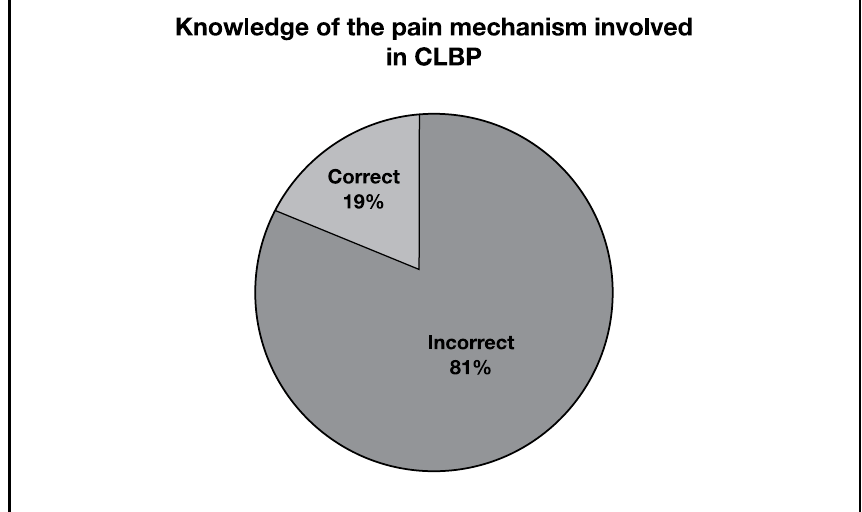
Figure 2: Knowledge of the pain mechanism involved in clBP (n=141)